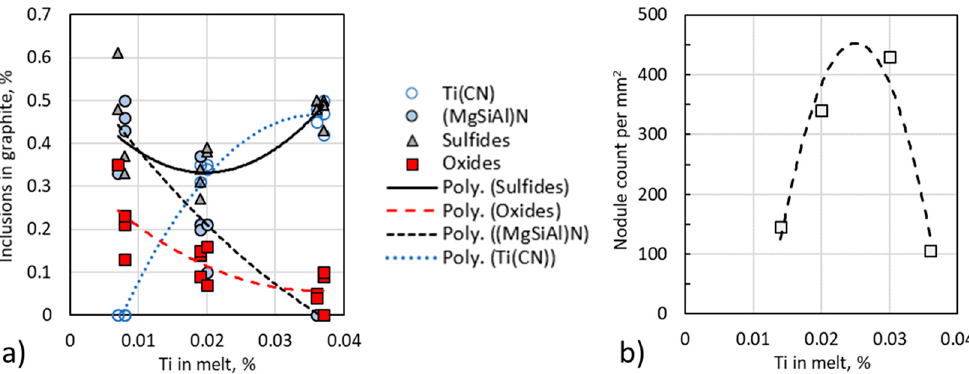
Figure 22. Effect of titanium content in the base melt: ( a ) On the composition of the inclusions found in graphite spheroids (all melts); ( b ) on the nodule count (not inoculated melts) [106].